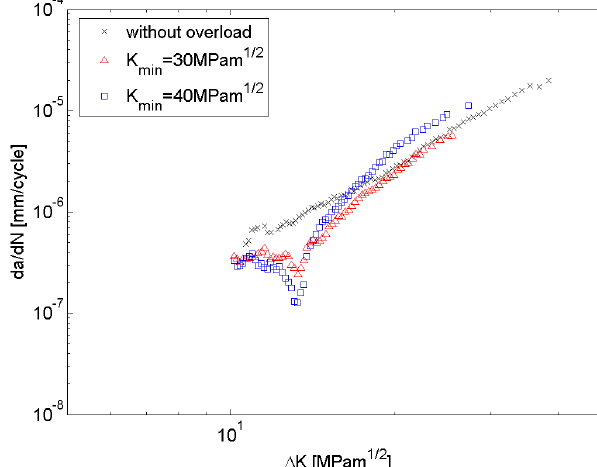
Figure 3: The experimentally obtained long crack fatigue crack growth behavior for a specimen with pre-cracks generated in cyclic compression and specimens with additional compression